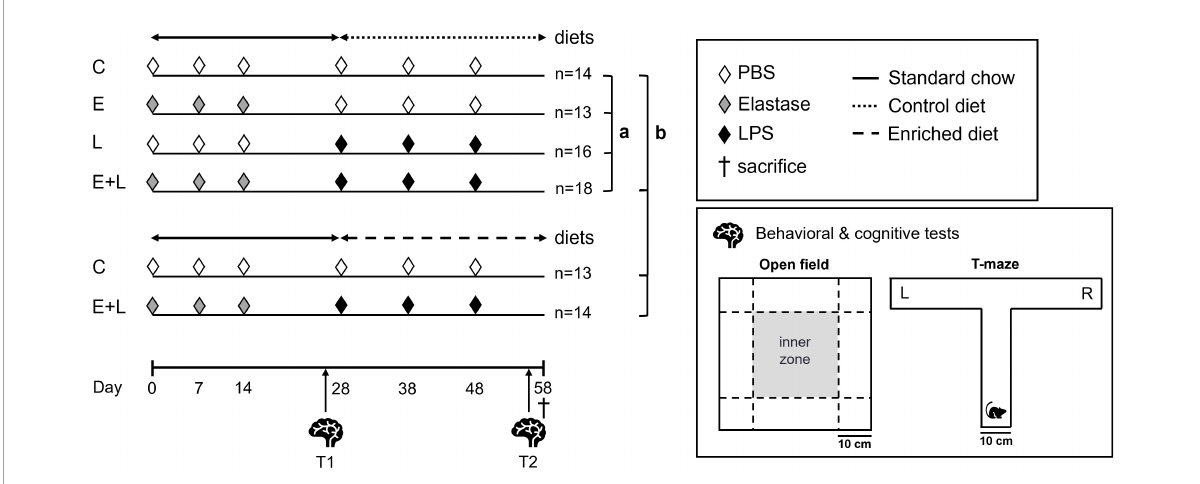
FIGURE1 Experimental design. Mice were intratracheally (i.t.) instilled with elastase or vehicle on days 0, 7, and 14. Mice received LPS or vehicle i.t. for three times on days 28, 38, and 48. The nutritional intervention was applied from the first LPS trigger onward until sacrifice at day 58. The following treatment groups were included: control (C), elastase control (E), LPS control (L), and elastase plus LPS (E + L). Additional C and E + L treated mice were exposed to a nutritional intervention. From day 0 until day 57, mice were fed a standard chow diet (solid line). The enriched diet (rough dashed line) or an isocaloric, isonitrogenous control diet (fine dashed line) was applied from the first LPS trigger onward until sacrifice at day 58. Behavioral and cognitive tests were performed at two time windows: just before the first LPS trigger (T1; days 25–27) and at the end of the study (T2; days 55–57). The open field and T-maze spontaneous alternation tests were used to assess novelty-induced behavior and cognition, respectively. Statistical analyses were performed in two steps, according to the two goals of this study: (a) to assess the impact